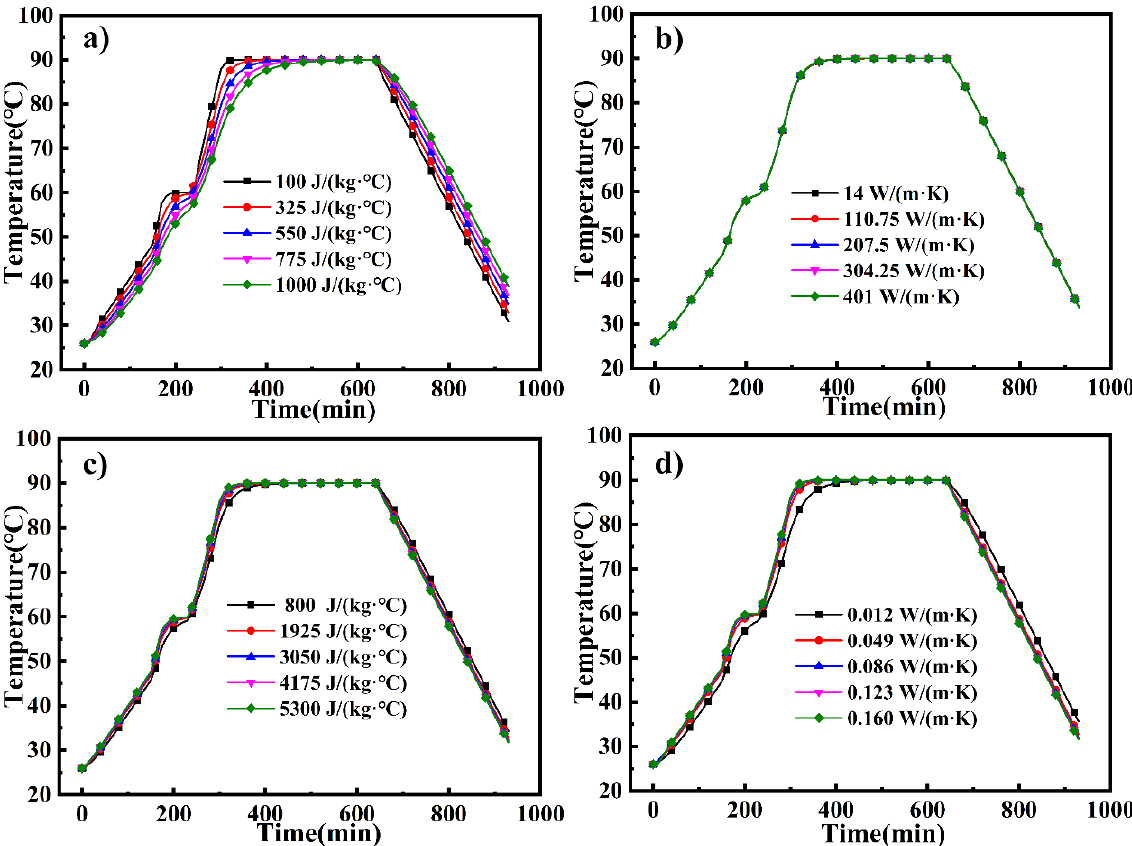
Figure 11. Average temperature of the mold plate as a function of ( a ) specific heat of the mold, ( b ) thermal conductivity of the mold, ( c ) specific heat of the fluid, and ( d ) thermal conductivity of the fluid.